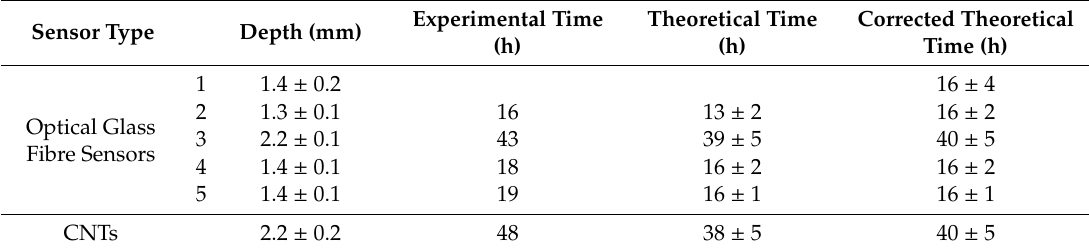
Table 1. Summary of the depth location and signal change of the di ff erent embedded optical fibre sensors and the GF ply spray coated with CNT in the